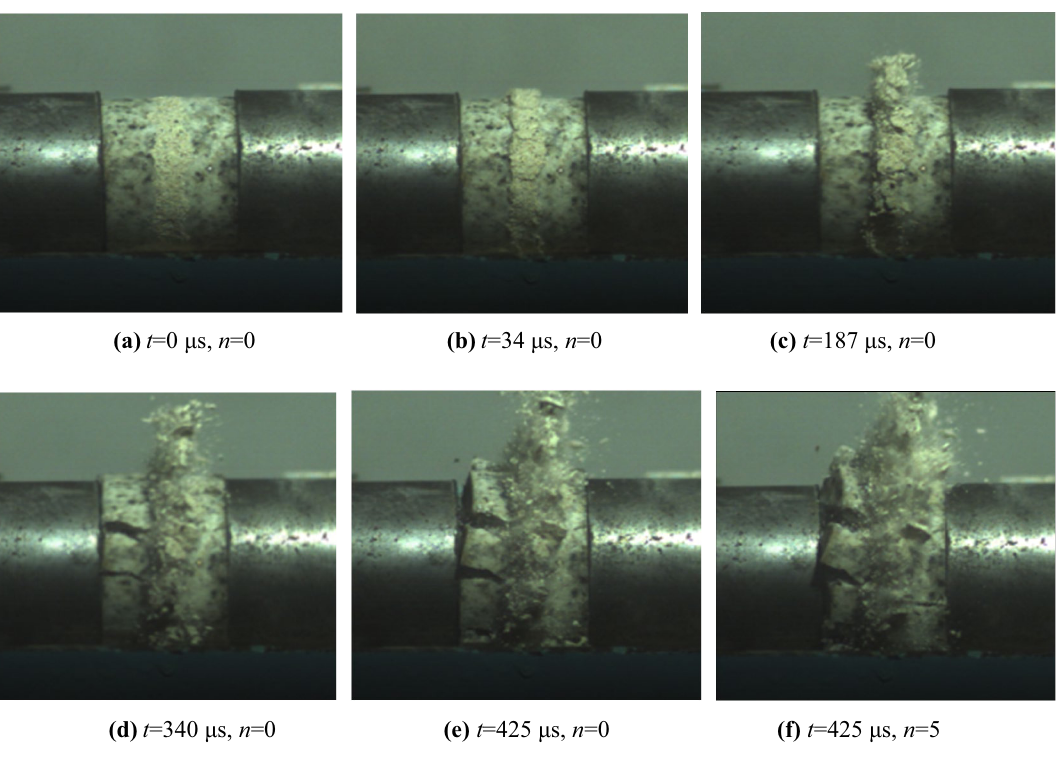
Figure 11. Photos of impact failure process of filled jointed rock